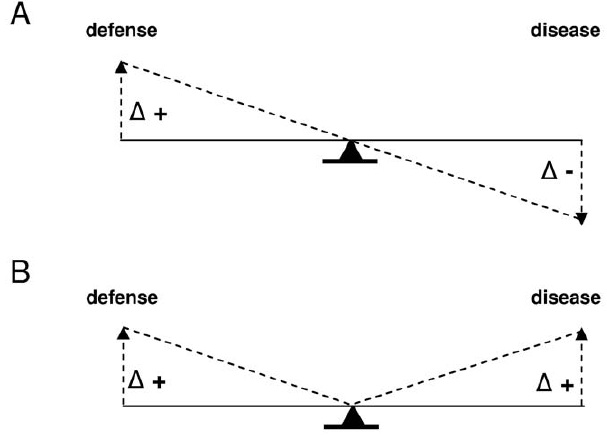
Figure 7. Different defense-disease relations illustrated by a ‘see-saw but see-see’ model. For Pectobacterium atrosepticum (A), the model describes the interaction according to the ‘see-saw principle’: increased defense is associated with decreased disease. For Phy- tophthora infestans (B), the model describes the interaction according to the ‘see-see principle’: increased defense is associated with increased disease. A plausible explanation for these differences is proposed by a general interaction model (Figure